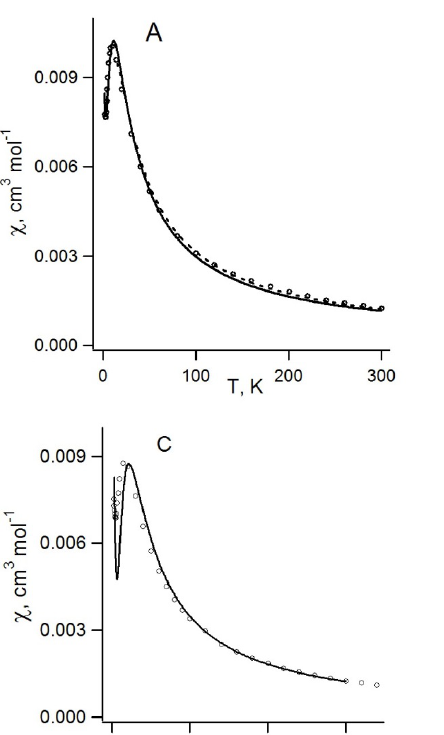
Figure 19. Experimental (circle) and theoretical (curves) temperature dependences of the molar magnetic susceptibility χ ( A , C ) and product χ T ( B , D ) for salts 74 (A, B) and 69 (C, D). Theoretical curves: high-temperature series expansion fit (A, B; dashed curves) and